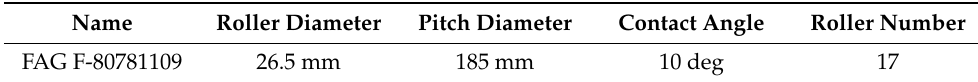
Figure 9. Three loading forces. ( a ) axial direction; ( b ) vertical direction. Table 3. Condition number of each running condition. Condition Number